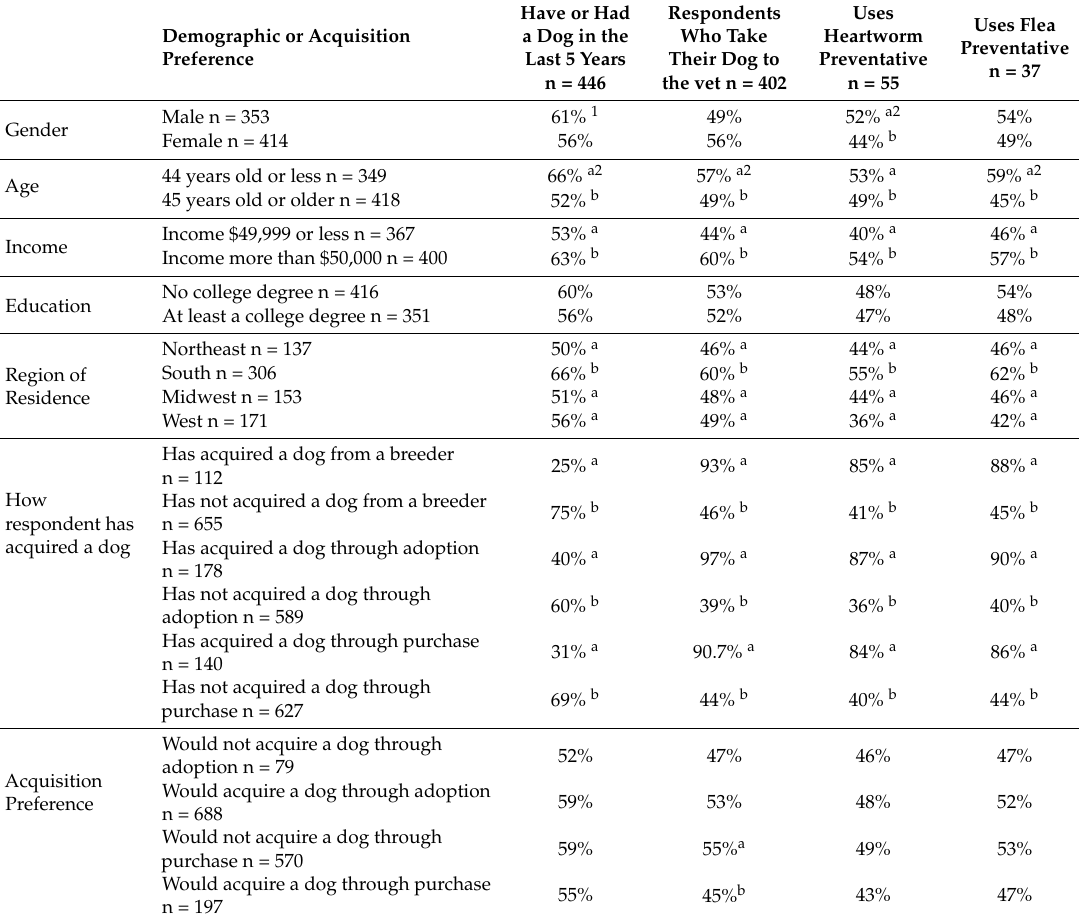
Table 5. Cross tabulations between respondent characteristics and dog ownership and dog